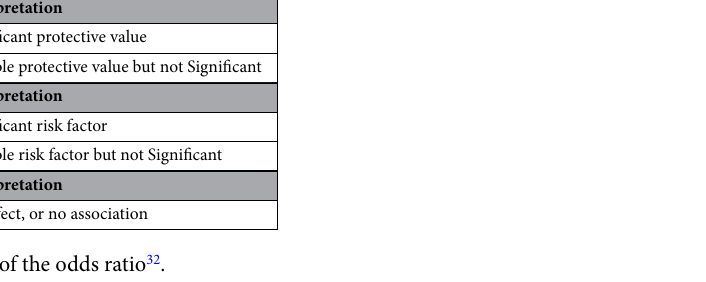
Table 2. Interpretation of the odds ratio 32